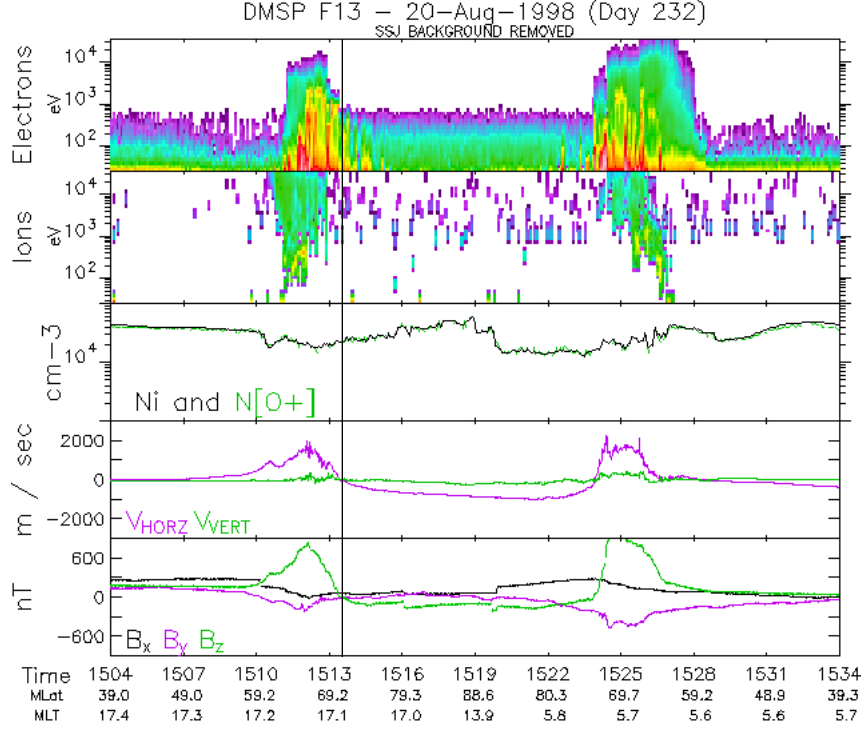
Fig. 13. Northern Hemisphere DMSP F13 data for the interval 15:04–15:34UT. Polar cap boundary is marked by vertical guideline. Event category: NH-dusk/ B y < 0